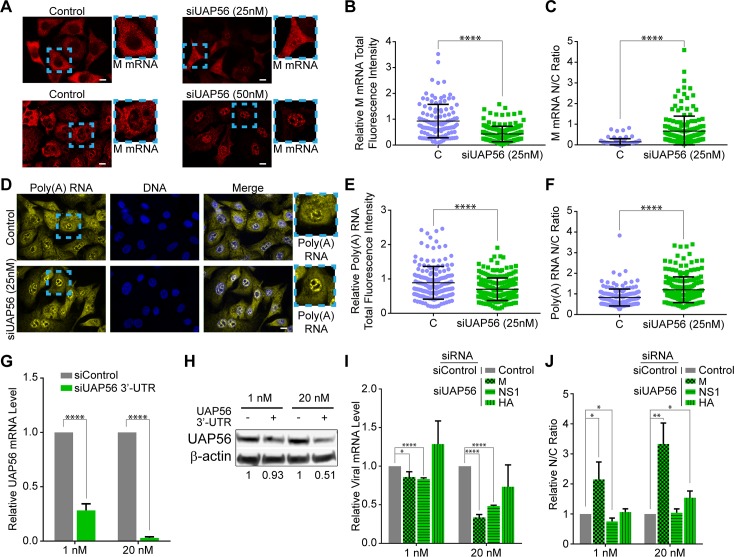
Partial depletion of the mRNA export factor UAP56 show differential export of viral mRNAs similar to compound 2.(A) smRNA-FISH followed by fluorescence microscopy was performed to detect M mRNA in A549 cells treated with control siRNA or with two concentrations (25 nM and 50 nM) of siRNAs that target the coding region of UAP56 or control siRNA followed by infection with WSN at MOI 2 for 8h. (B) Total fluorescence intensity or nuclear to cytoplasmic fluorescence intensity (N/C ratio) (C) were quantified for images in A in which cells were treated with 25 nM siRNA targeting UAP56. For B (C, n = 117 cells; siRNA UAP56, n = 171 cells) and C (Control, n = 97 cells; siRNA UAP56, n = 166 cells). Graphs show data points and mean +/- SD. ****p<0.0001. (D) A549 cells were treated with 25 nM siRNA targeting UAP56 or control siRNA as in A. RNA-FISH was performed to detect poly(A) RNA. Total fluorescence intensity (E) or nuclear to cytoplasmic fluorescence intensity (F) were quantified for images in D. For (E) (C, n = 171 cells; siRNA UAP56, n = 213 cells) and F (Control, n = 172 cells; siRNA UAP56, n = 208 cells). Graphs show data points and mean +/- SD. ****p<0.0001. (G-J) A549 cells were treated with 1 nM or 20 nM siRNA targeting the 3’UTR of the UAP56 mRNA or with control siRNA and then infected with WSN at MOI 2 for 8h. (G) Purified RNA from total cell lysates was subjected to qPCR to measure UAP56 mRNA levels. (H) Cell lysates were also subjected to western blot to detect UAP56 protein and β-actin as control. Quantification of protein bands normalized to their loading control is shown at the bottom of the blots. (I) Purified RNA from total cell lysates in (G) were subjected to qPCR to measure viral mRNA levels. (J) Purified RNA from nuclear and cytoplasmic fractions from cells treated as in (G-J) were subjected to qPCR to measure viral mRNA levels in both fractions and determine their nuclear to cytoplasmic ratios (N/C). Control for cell fractionation is shown in S3 Fig. n = 3. Graphs are mean +/- SD. *p<0.05, **p<0.01, ****p<0.0001.